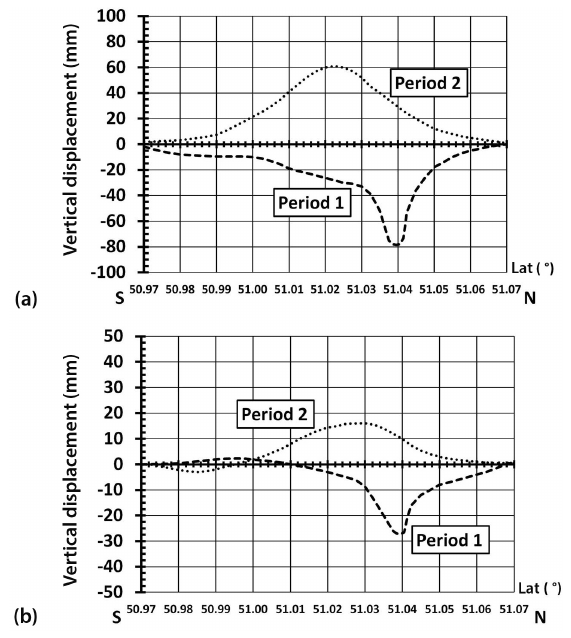
Figure 9. Smoothed curves fitted for the total surface movement along a north–south transect, situated for a longitude between 5.37 and 5.38 ◦ E: (a) the two 5-year time zones (see Figs. 4a and 7a respectively); (b) the two 2.5-year time zone (see Figs. 4b and 7b respectively).